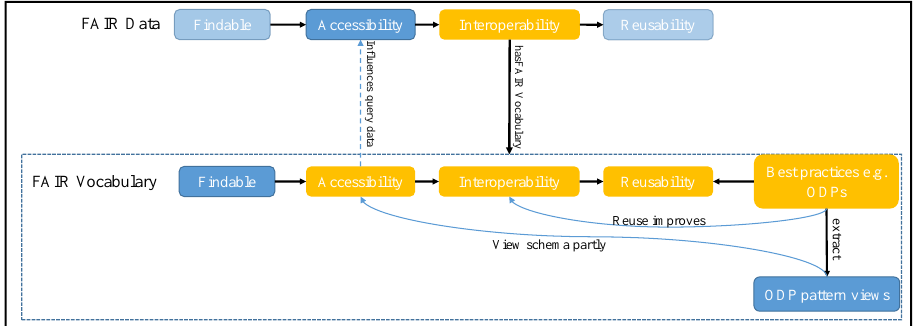
Figure 6. Example of Relationships in FAIR